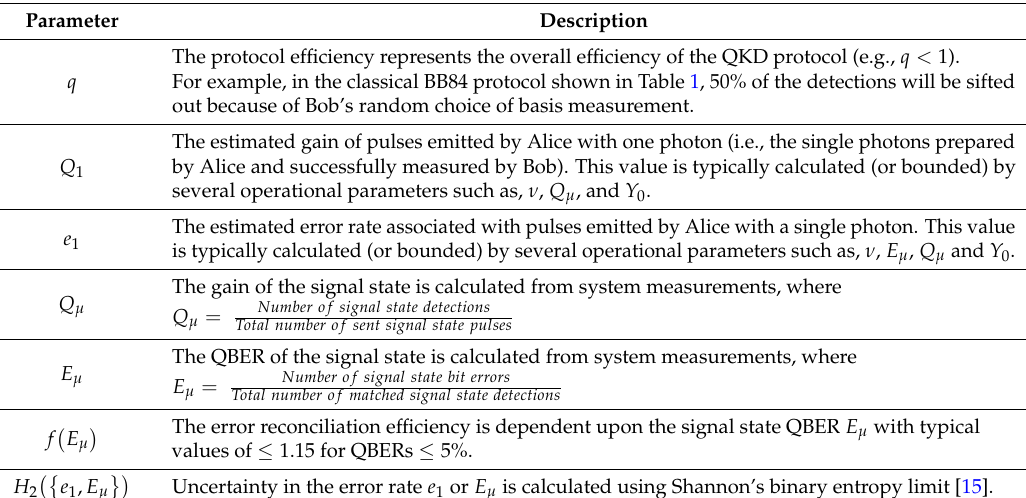
Table 3. Secure Key Rate Parameters